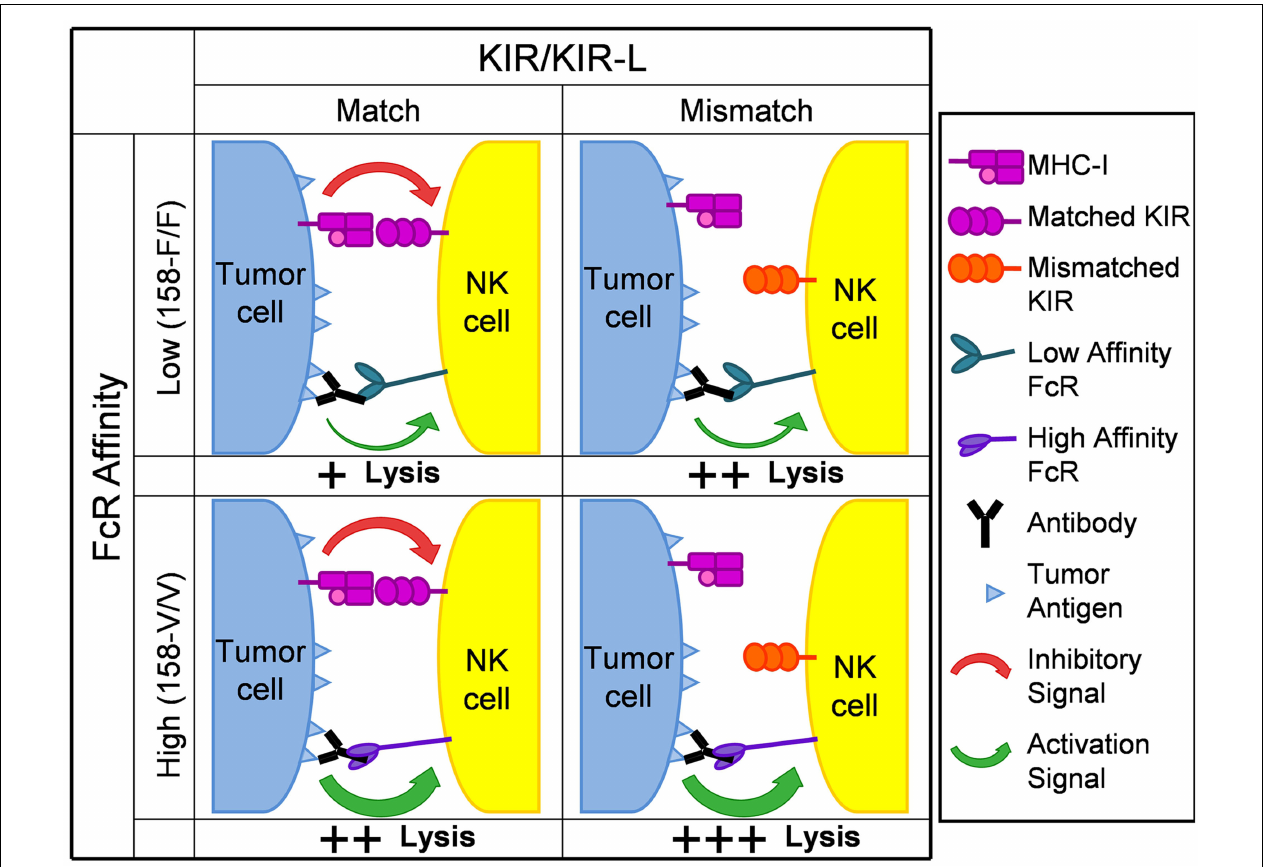
interaction of Fc and the distinct CD32 polymorphisms expressed on neutrophils, monocytes and macrophages.The overall response will reflect the balancing of the signal activating tumor lysis (depicted as a green arrow) with the inhibitory effect of KIR ligation (depicted as a red arrow).The poorest response/least tumor cell lysis (designated + ) would result from having low affinity FcRs and being KIR/KIR-L matched (upper left quadrant).The best response/greatest tumor cell lysis (designated +++ ) would result from having high affinity FcRs and being autologous KIR/KIR-L mismatched (lower right quadrant). Having either low affinity FcRs and being KIR/KIR-L mismatched (upper right quadrant) or having high affinity FcRs and being KIR/KIR-L matched (lower left quadrant) would result in an intermediate response/level of tumor cell lysis (designated ++